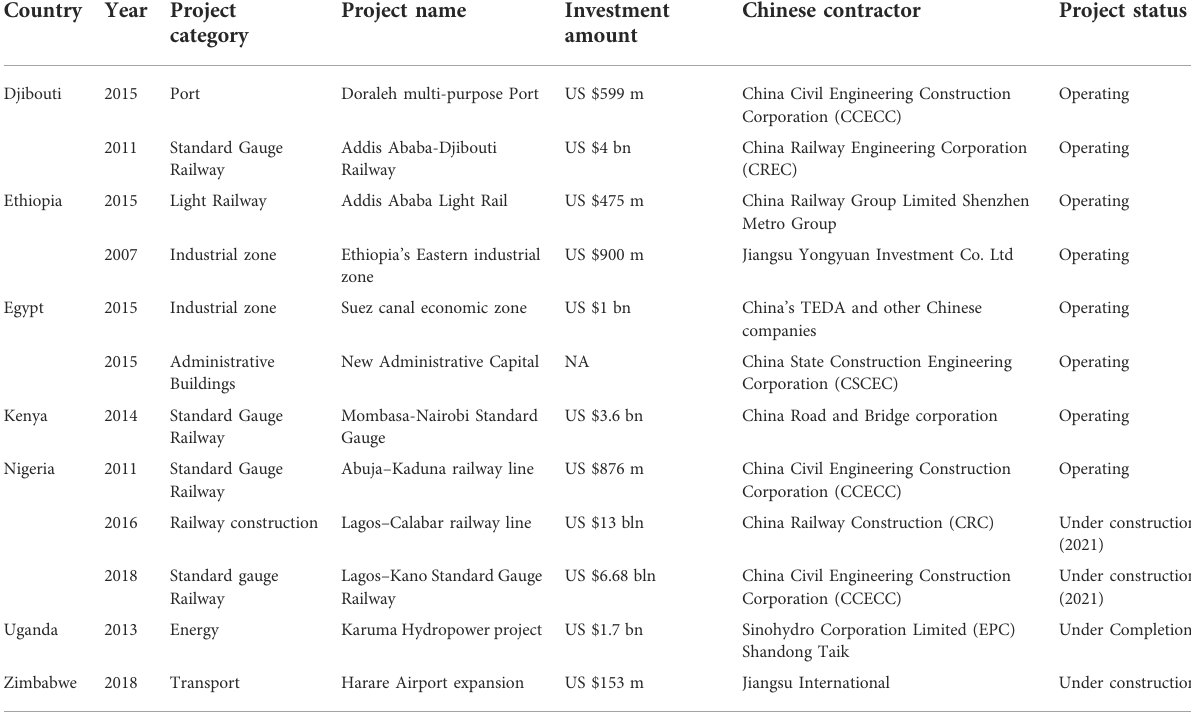
TABLE 1 Chinese FDI projects in